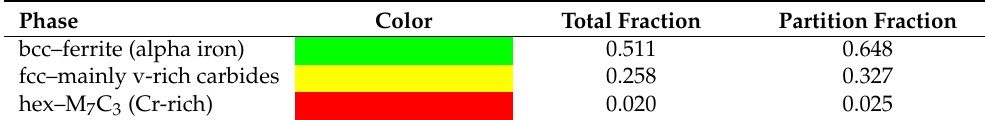
Figure 7. EBSD measurements on the as-built cross section of the open thin-walled cylinder in build direction: ( a ) EBSD phase map; EDX measurements showing the distribution of ( b ) carbon; ( c ) chromium; ( d ) iron; ( e ) vanadium. Build direction is rotated by 90 ◦ and indicated by a white arrow. Table 2. Summary of the phases detected in as-built FeCr-10V by EBSD. Colors refer to Figure